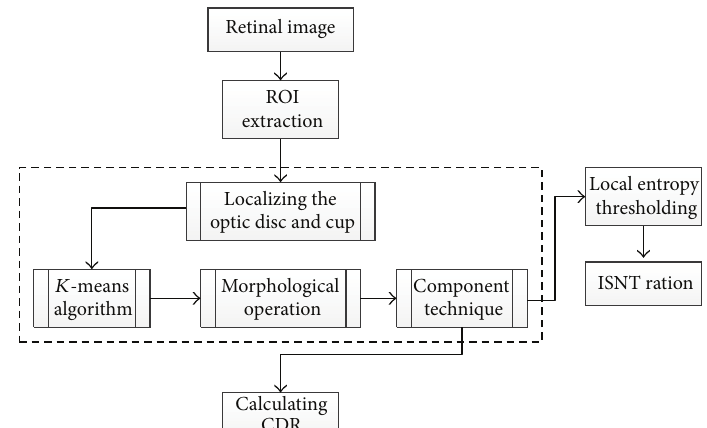
Figure 37: Flowchart for algorithm proposed in [60].